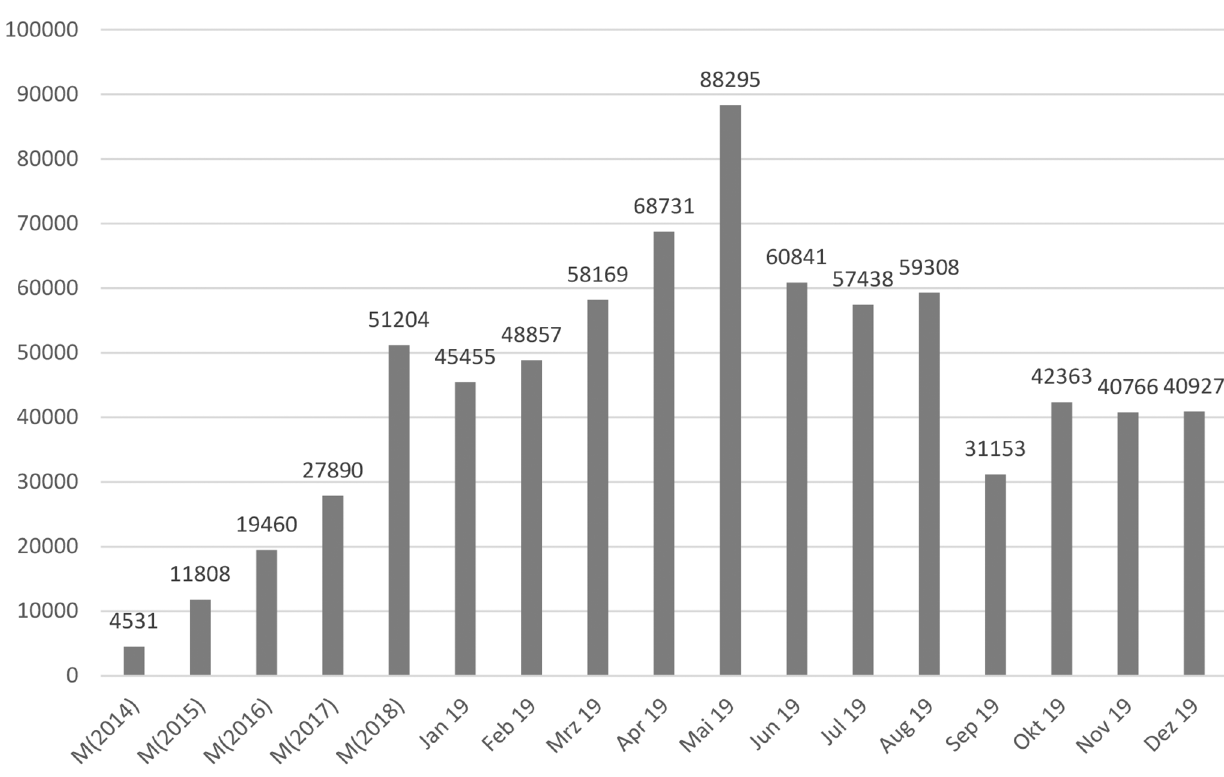
Figure 1. Number of article downloads per month in 2019.